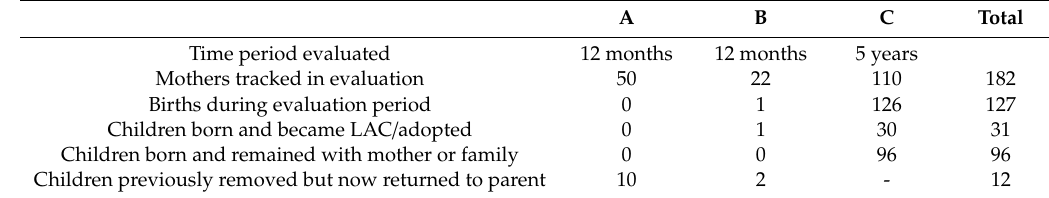
Table 2. Births and removals of